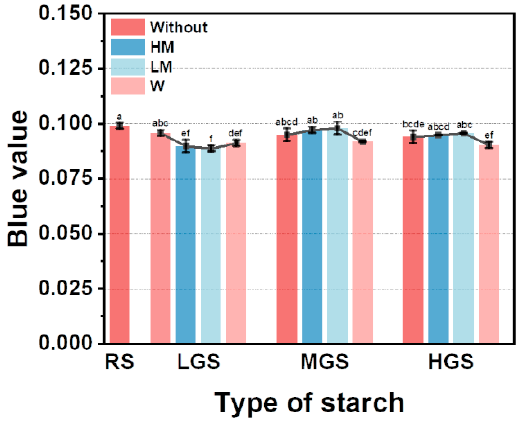
Figure 6. Blue value of PGSs reheated by different methods. Different letters indicate significant differences ( p <